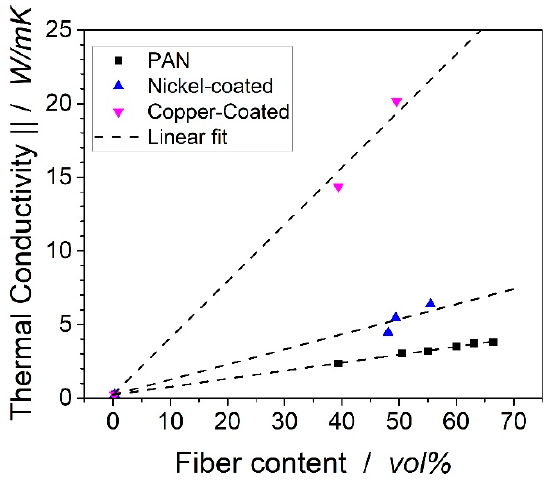
Figure 6. Thermal conductivity vs. fiber volume content for the in-fiber direction. The standard deviation is not visible in the graphs.